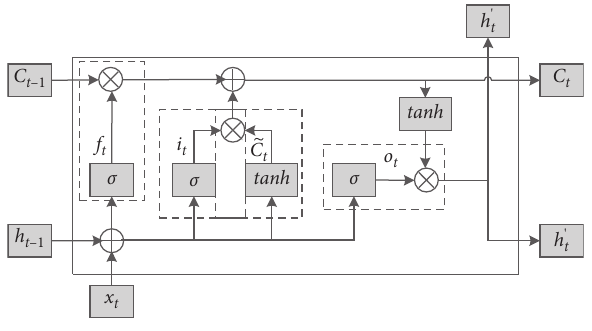
Figure 1: LSTM structure diagram at the t -th